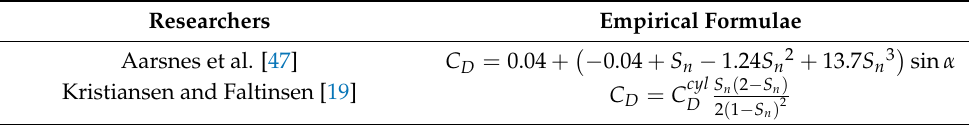
Table 2. Analytical models for estimating the drag coefficients.